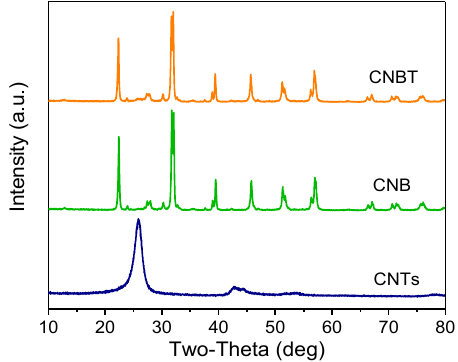
Figure 5. XRD patterns of CNTs, CNB, and CNBT.